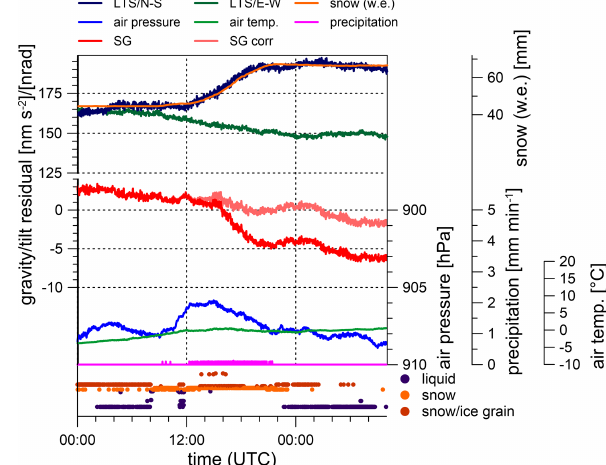
Figure 8. Effect of snow accumulation on gravity and tilt at CO on 21 and 22 December 2017. The legend indicates the following, from top to bottom: N–S tilt residuals (dark blue), E–W tilt residu- als (dark green), snow (water equivalent – orange) scaled to fit the N–S tilt optimally, SG gravity residuals (red), gravity corrected for cumulative precipitation (light red), air pressure (blue) and outdoor air temperature